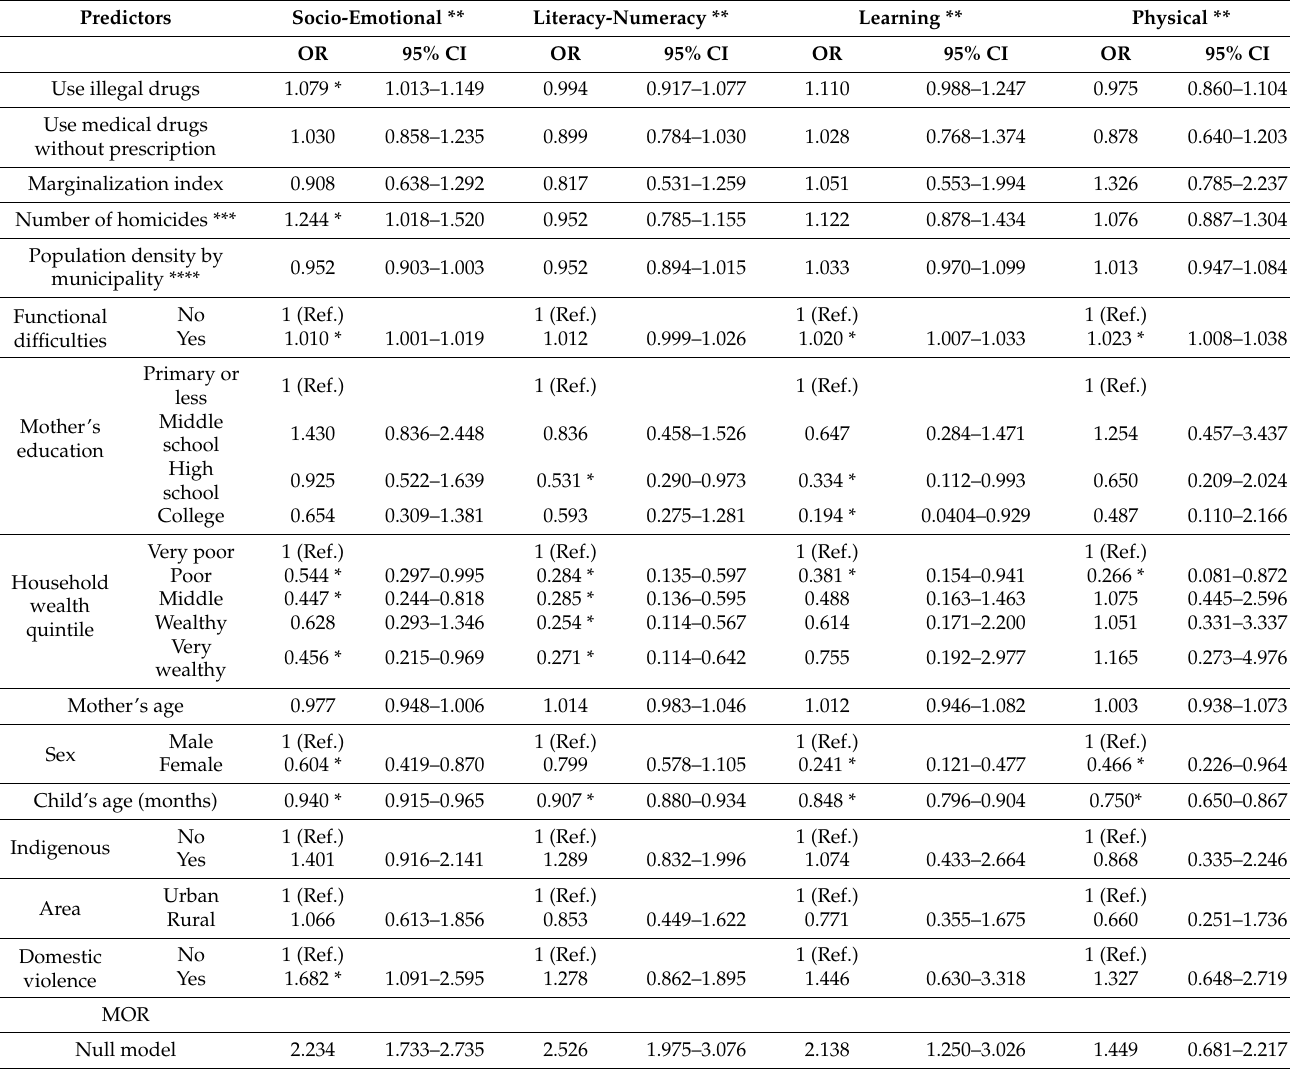
Table 4. Adjusted Associations Between Psychoactive Substance Use and Inadequate Early Childhood Development, by